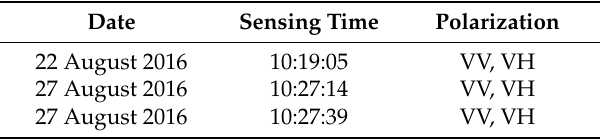
Table 4. Description of Sentinel-1A products used in this